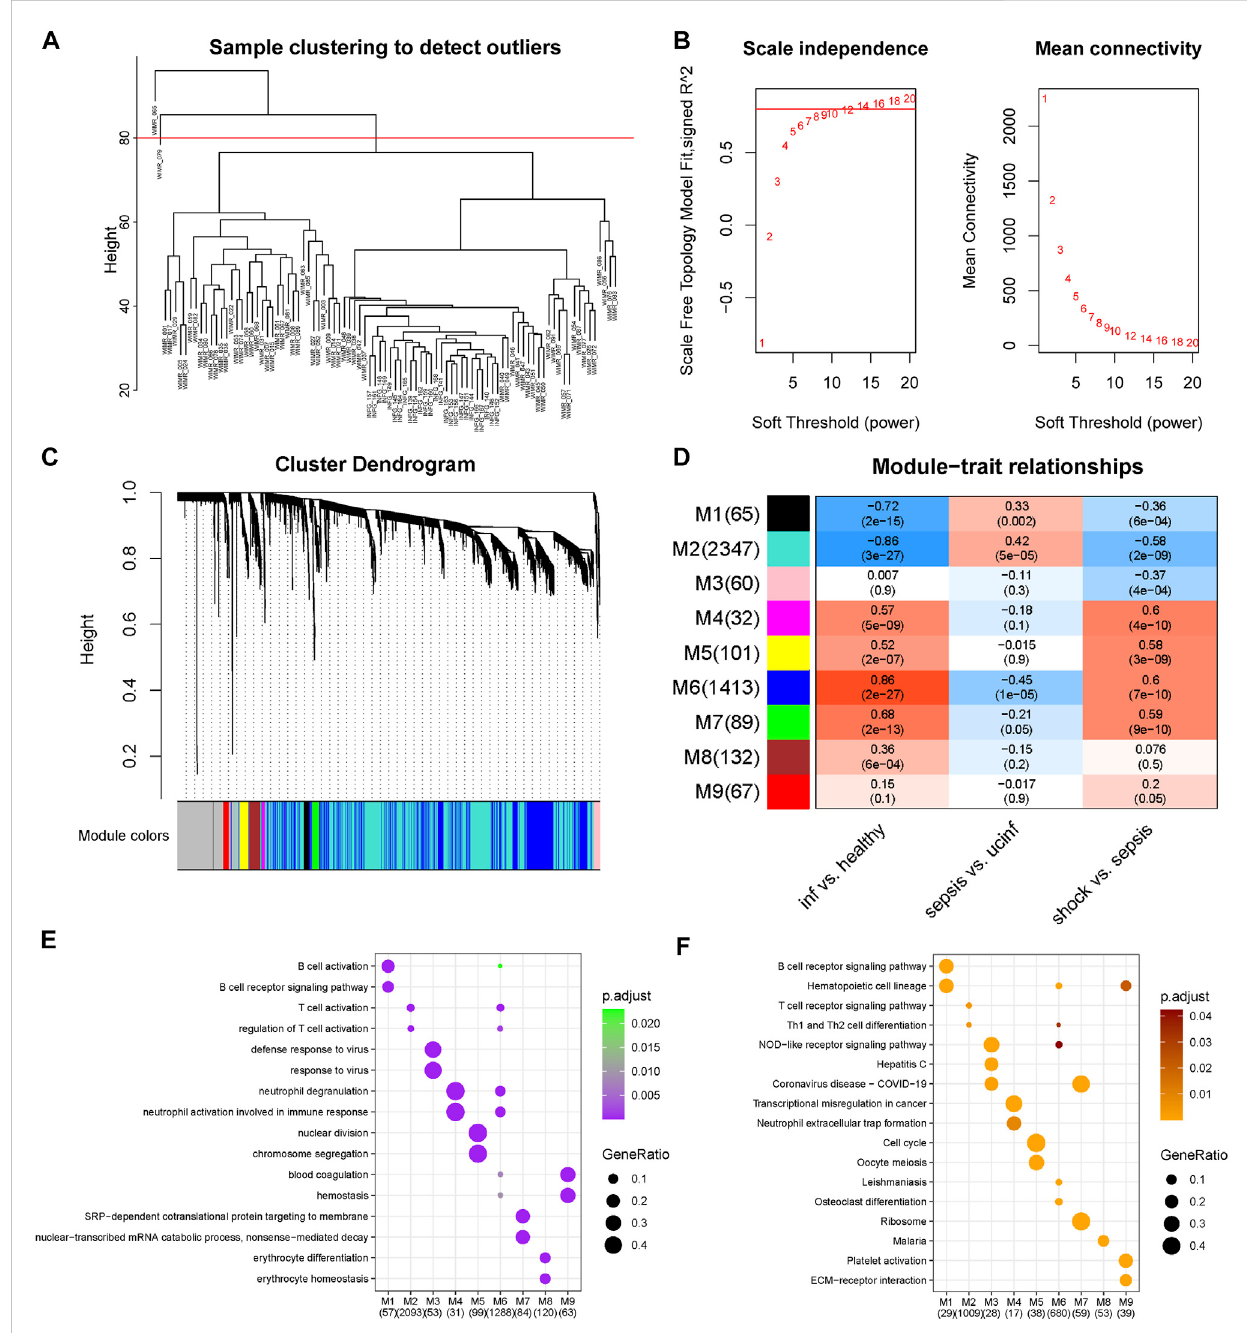
FIGURE 3 Co-expression network construction. (A) Hierarchical clustering dendrogram of adopted samples to detect outliers. (B) Determination of optimal soft-thresholding power. (C) Hierarchical clustering dendrogram and corresponding modules of involved genes. (D) Correlation heatmap of module eigengenes and phenotypes. The color of the squares gradually from blue to red represents the Spearman correlation coef fi cients. (E) Biological processesenrichedineachmodule,thecolorandthesizeofthedotscorrespondedtothesigni fi canceofenrichmentandtheratioofenrichedgene numbers in the corresponding terms respectively. (F) KEGG pathways enriched in each module, the color and the size of the dots corresponded to the signi fi cance of enrichment and the ratio of enriched gene numbers in the corresponding terms